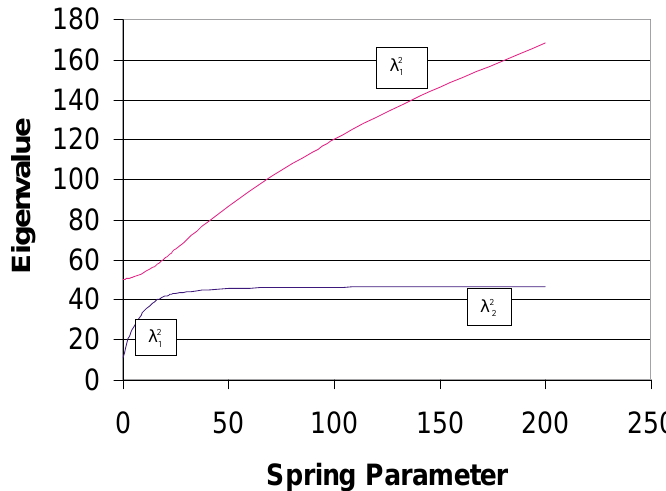
Fig. 8. Eigenvalues of simply supported beam with intermediate spring support (approximate deflection functions, α = 0 . 475